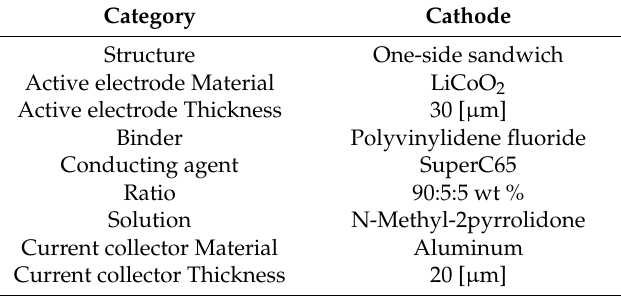
Table 1. Cathode manufacturing